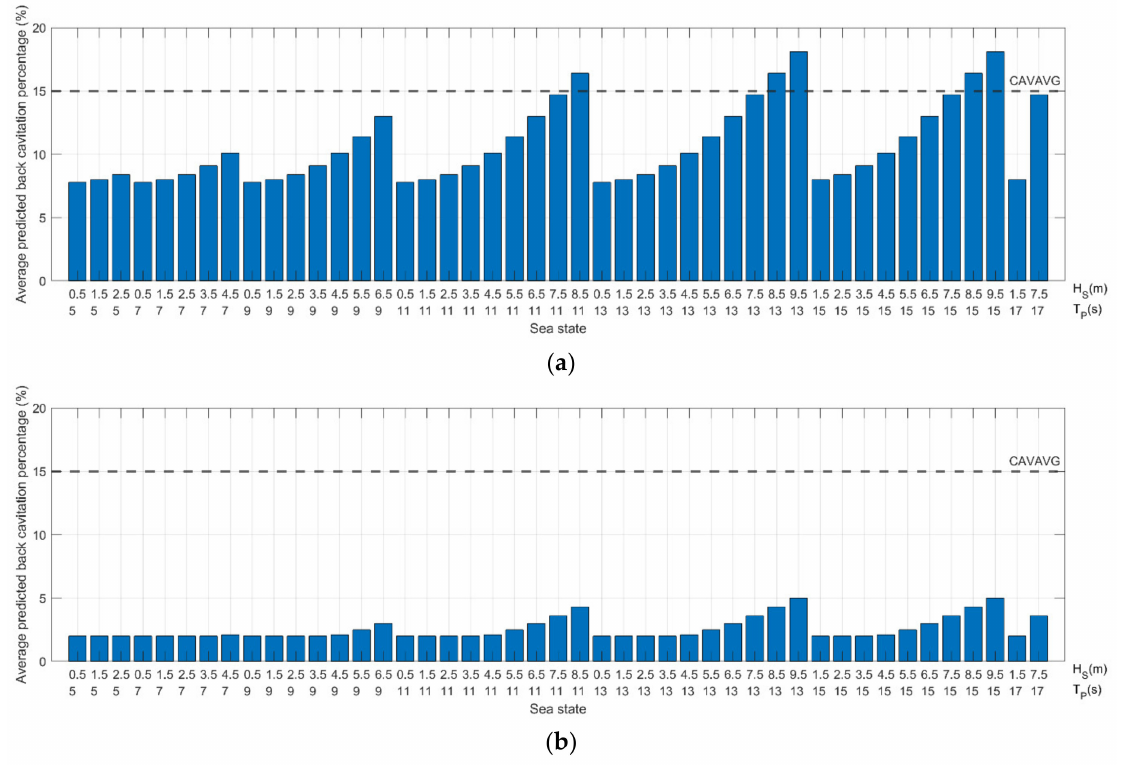
Figure 10. Variation of average back cavitation percentage for different sea states. ( a ) no cup, ( b ) heavy